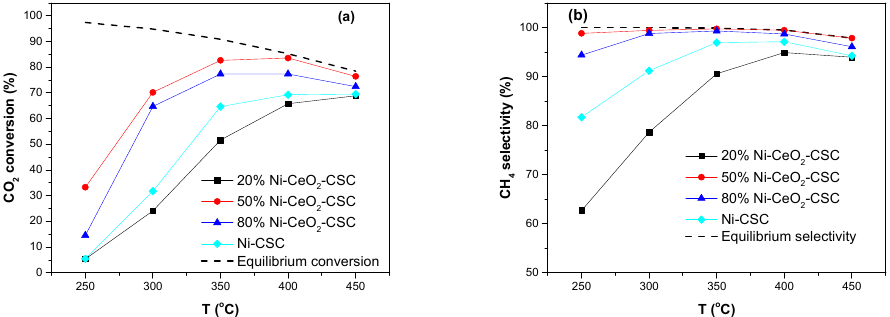
Figure 5. ( a ) CO 2 conversion and ( b ) CH 4 selectivity of the Ni-CeO 2 -CSC catalysts in CO 2 methanation.